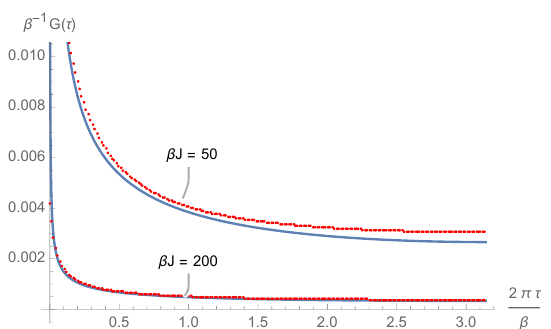
Figure 2. Comparison of numerical (red) and analytic (blue) solutions of the regularized bosonic Schwinger-Dyson equations (2.17) for two di(cid:11)erent values of (cid:12)J as indicated. The numerical sim- ulation is carried out with the imaginary time circle discretized by a lattice with 200 points (see footnote